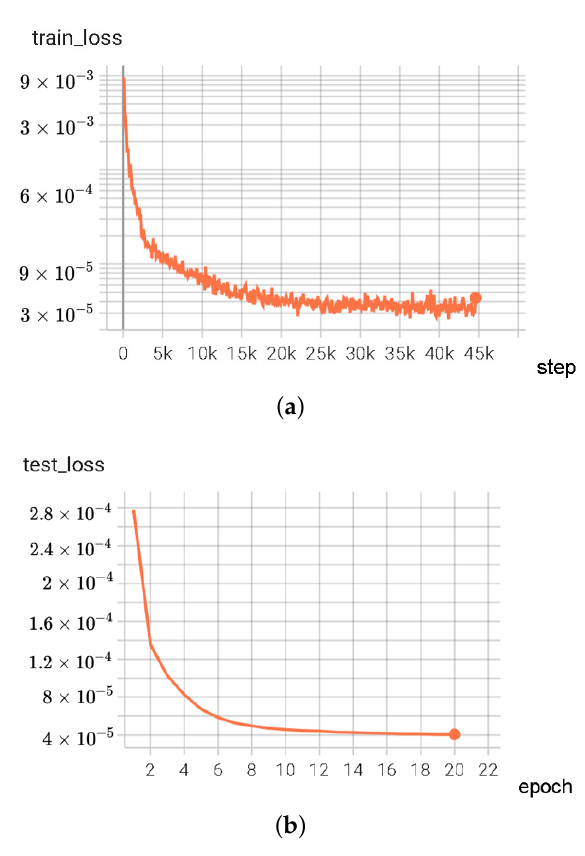
Figure 9. Train loss and test loss. ( a ) train loss; ( b ) test